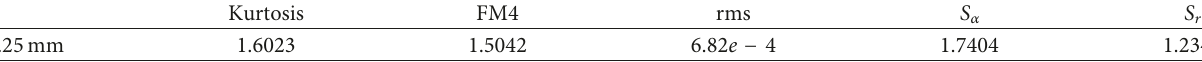
Table 7: Indicators of the vertical acceleration of car body vibration when crack length is 3.25.